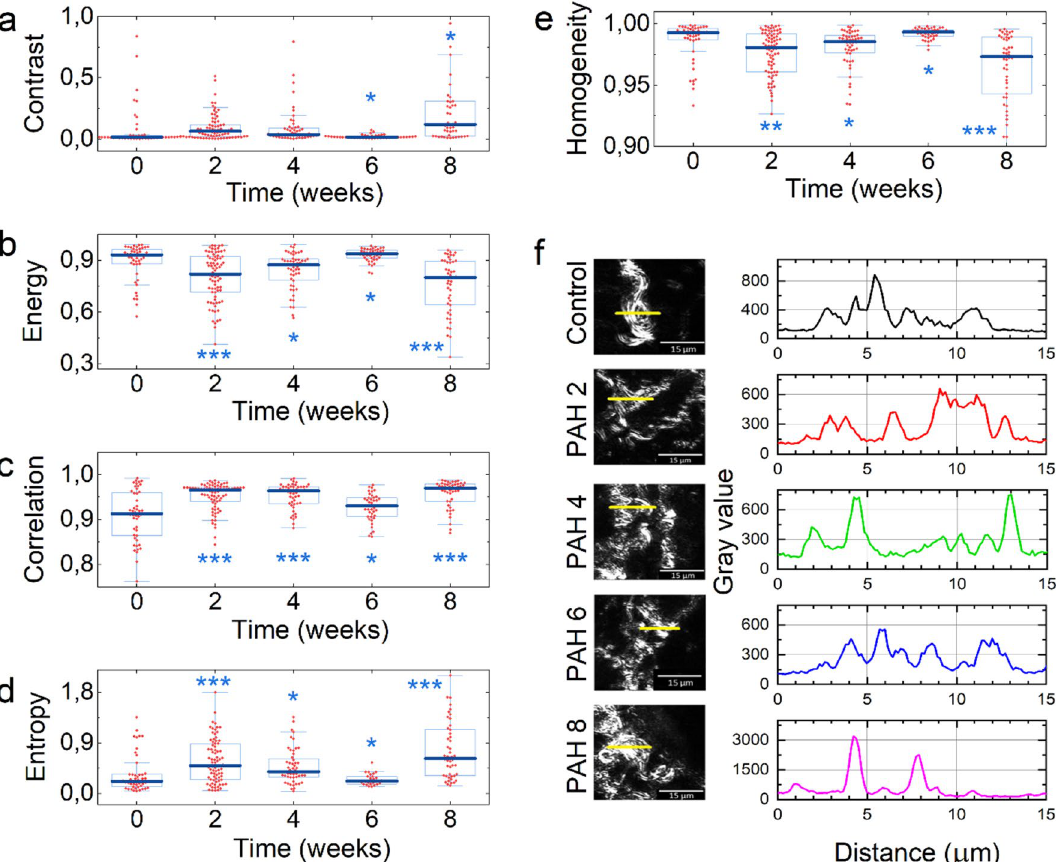
Figure 5. SOS parameters calculated on images of control samples of healthy lung tissue and at different stages of PAH progression. ( a ) Inertia (contrast), ( b ) energy, ( c ) correlation, ( d ) homogeneity, ( e ) entropy, ( f ) typical SHG collagen structures (scale bar 15 μm). The statistical significance of the difference of distributions relative to the control is p < 0.1*, p < 0.01**, p < 0.001***). Regions of interest (ROIs) size is 150 × 150 μm 2